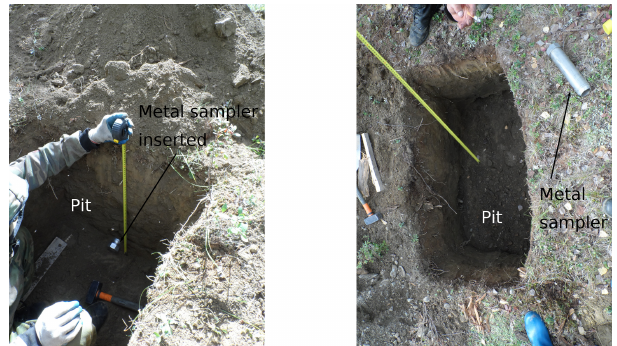
Figure A1. Sample pits and sampler usage on the Ulakhan fault scarp. Sampler is inserted at the deepest part of the pit, usually by hammering, then extracted by hand.